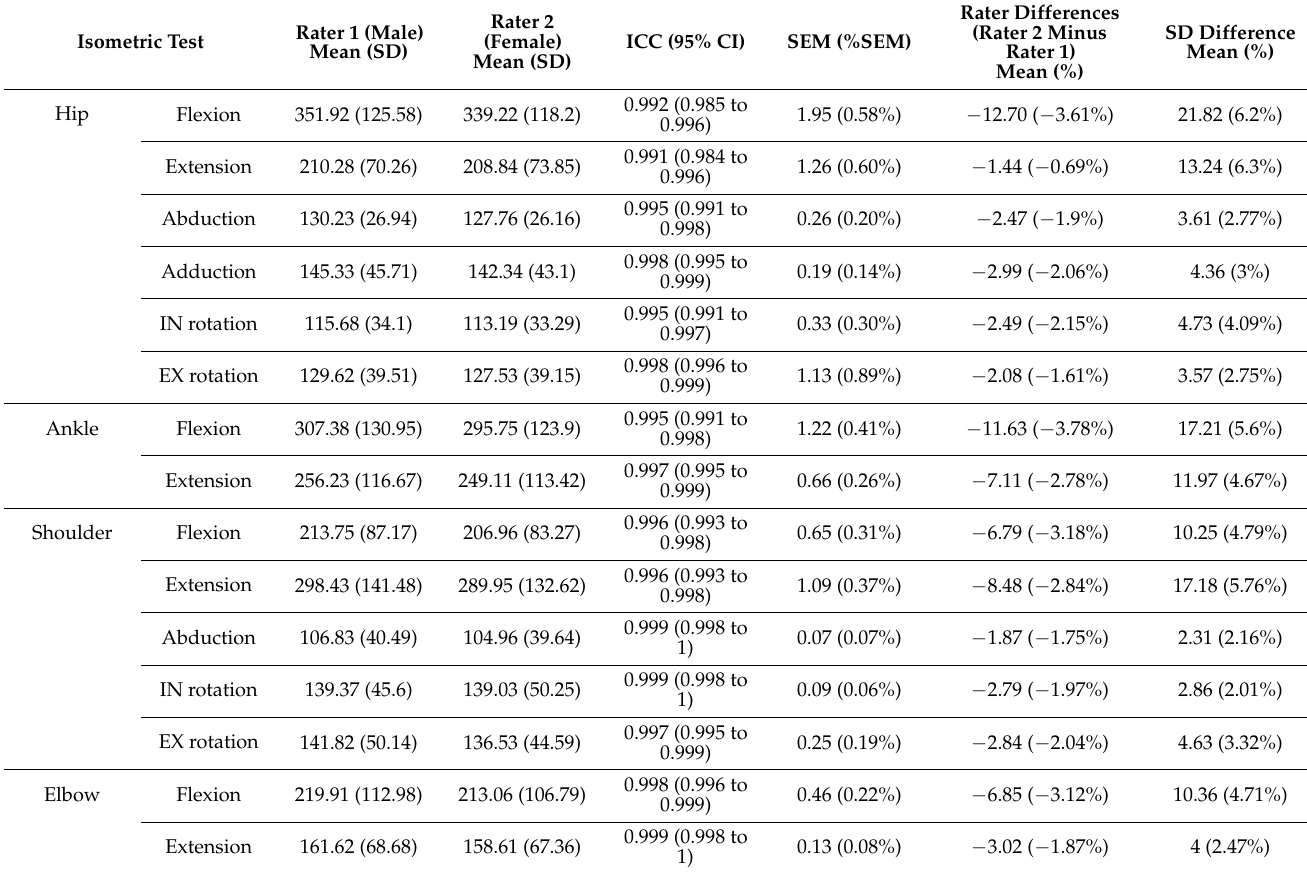
Table 3. Inter-rater reliability and agreement for pull HHD method by movement.